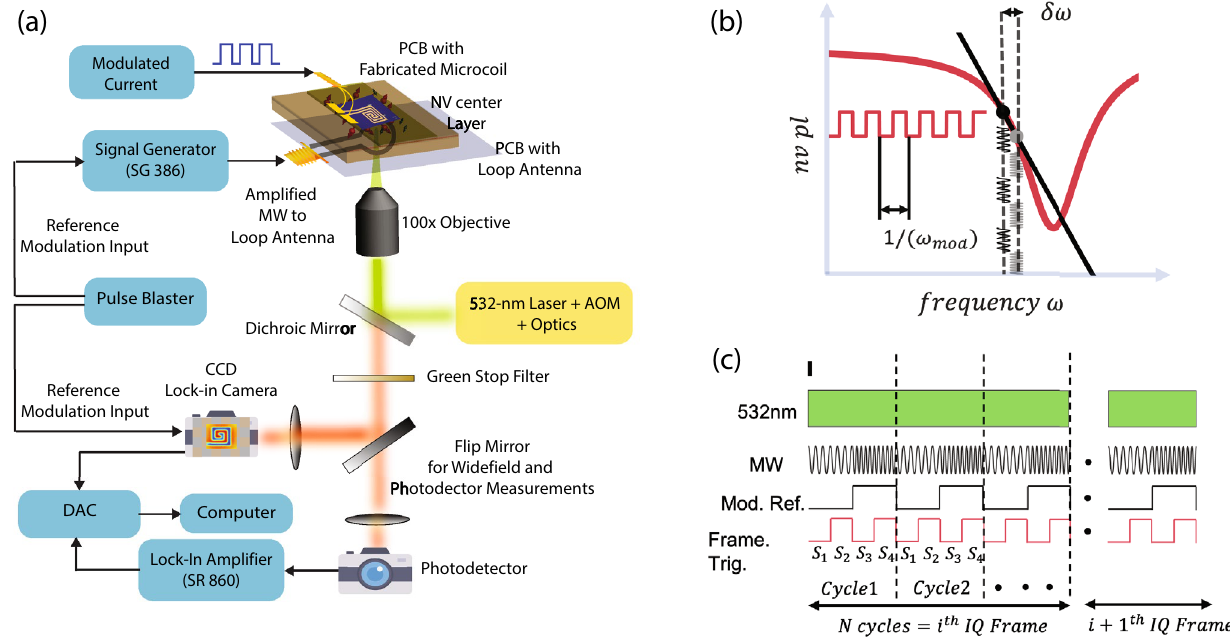
Figure 1. Schematic of the experimental setup and protocol for data acquisition: ( a ) Schematic describing the experimental setup for single photodiode diamond NV magnetometry (SP) or widefield per pixel lock-in diamond nitrogen-vacancy magnetometry (WM) ( b ) Illustration explaining generation of frequency modulated NV emitted red light by applying frequency shift key type microwave resonant frequencies. The ω dev in sync with square wave waveform applied microwave resonant frequencies shuttle between ω and ω − of frequency ω mod . When the microwave frequencies are resonant, the emitted NV red light is frequency modulated at ω mod ( c ) Pulse protocol to control and synchronize the demodulation of internal camera frames with modulation frequency of optical signal to obtain lock-in in-phase (I) and quadrature (Q) images. A green laser illumination at 532-nm is continuously on and frequency shift key microwave (MW) waveform with modulation ω mod is applied. Lock-in camera external trigger pulses, controlling internal frame acquisition timings, are provided at 2 ω mod , synced with MW modulation, where they define 4 quarters for light integration S S S S S S S S 1 2 3 4 . These four quarters of light integration allow in-phase ( 1 3 ) and quadrature ( 2 4 ) estimation − − of optical signal and are averaged over N cycles to give single pair of In-phase image and Quadrature Image (IQ Figure 1a is an illustration of the experimental setup used to perform diamond NV magnetometry. A non-resonant green light excitation at 532 nm (Sprout Laser) is used to illuminate NV centers via a 100 objective (Olympus, MPLFLN series). The excitation beam is focused on the back focal plane of the × 200 µ m diameter spot size on the NV layer. Optical power impinging the objective back objective to obtain ∼ 1.5 W. We use an isotopically pure diamond crystal (procured from Element Six) of lateral dimen- aperture is ∼ 4.5 mm and 500 µ m thick with a thin 1 µ m NV NV sions 4.5 mm − implanted layer of 1–2 ppm − concentra- × 110 tion. The diamond crystal has {100} front facet and edge orientation. The emitted light from NV centers is (cid:31) (cid:30) collected via the same objective, filtered to select the red light (above 567 nm) and reject green excitation light at 532 nm using a notch stop filter (SEMROCK NF03-532E-25). The collected light is focused onto a widefield lock-in camera (Heliotis Helicam C3) to perform widefield magnetometry. The diamond sample is mounted on a microwave loop PCB, and associated microwave electronics are used to deliver amplified microwave frequen- 2.5 to 3.2 GHz. The applied microwave frequencies follow frequency shift keying waveforms cies in the range ∼ with square-wave envelopes. The camera imaging frames are synchronized with the microwave modulation with specific pulse sequences generated by a high-speed TTL pulse generator card (SpinCore PulseBlaster ESR- PRO 500 MHz). Samarium-Cobalt (Sm–Co) ring magnets are used for applying a bias magnetic field and have 10 µ m track-width not been shown in the experimental schematic. Two microscale conductive samples, a ∼ 10 µ m track width planar spiral microcoil was fabricated on two independent silicon sub- microwire and a ∼ strates. Sample patterning was done using e-beam lithography followed by 100 nm thick deposition of Ti/Au. 400 (cid:31) . These samples are mounted on a custom PCB Typical resistances of these structures were found to be ∼ and wire-bonded to supply the drive voltage. The entire assembly was then glued with Loctite (cyanoacrylate glue) to the diamond crystal. Due to the back focal plane focusing, the 100 objective used in this work suffered a × damage in the center of the imaging field of view (FOV) because of high optical intensity localized in a very small area. Consequently, a small number of pixels in the FOV center have zero or minimal ODMR response and can be observed as a small blank hole in all magnetometry related images (for example see Fig. 3a and Fig. 4c,f,g). Experiment control and data analysis were performed from custom written codes in MATLAB 42 . Figure editing and assembly used Adobe Illustrator software 43 .